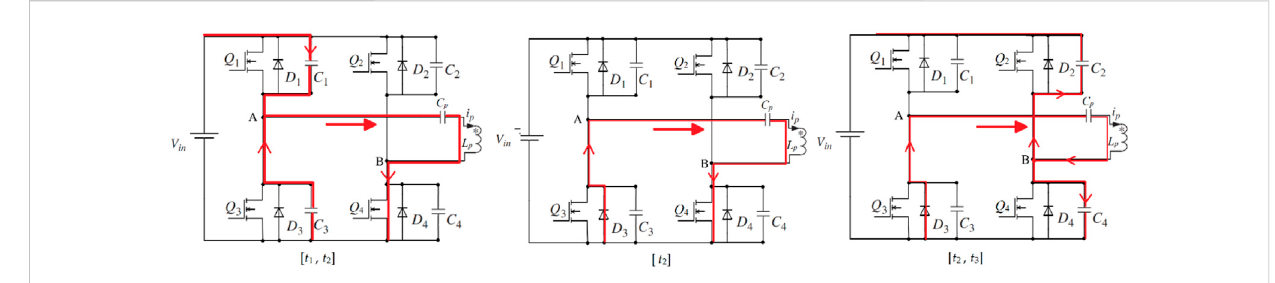
FIGURE 4 Equivalent circuits of different switching modes in hard-switching condition.